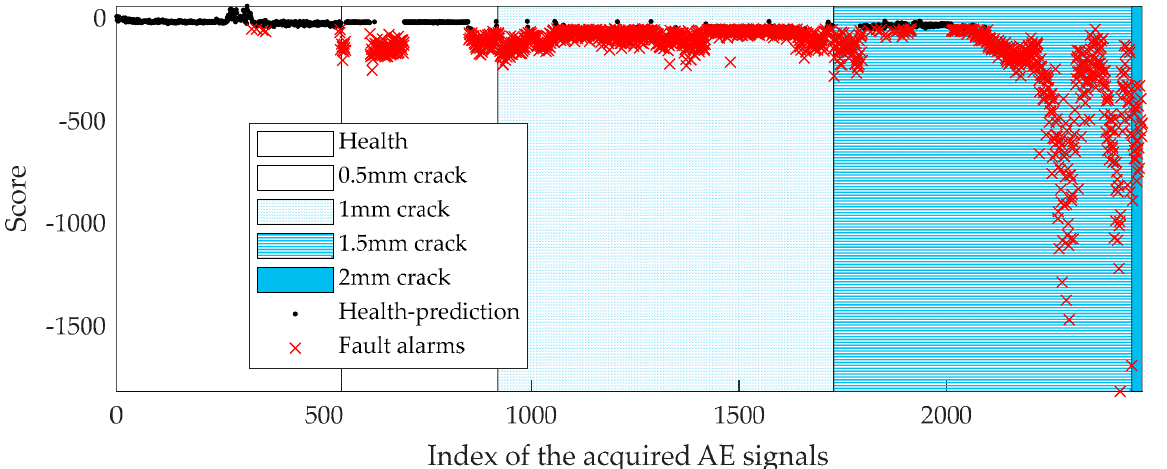
Figure 11. The generated 𝐸𝐻𝐼 of the acquired AE signals.